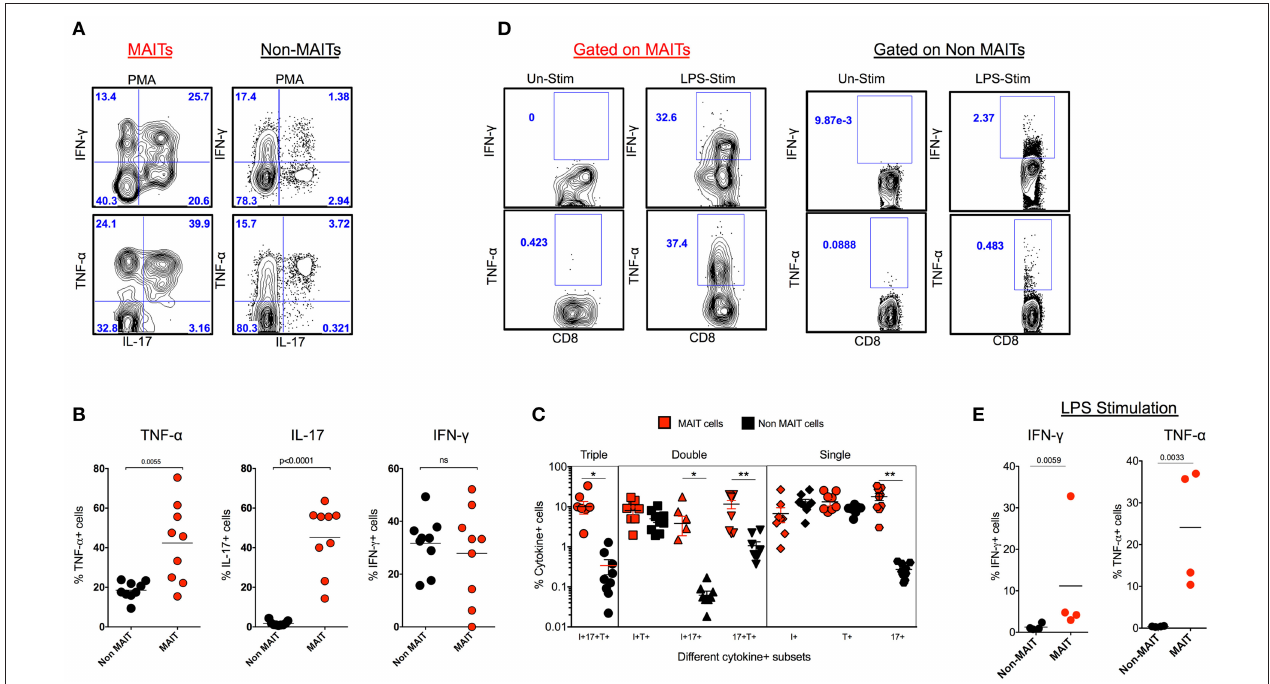
FIGURE 2 | MAIT cells are polyfunctional, and they predominantly make IL-17 in SHIV-naïve rhesus macaques. (A) Representative flow plots showing the production of cytokines IFN- γ , TNF- α and IL-17 by MAIT and non MAIT cells from SHIV-naïve animals. (B) Cumulative data for the production of cytokines from MAIT (red) and non-MAIT cells (black) from 9 SHIV-naïve animals stimulated with PMA/ionomycin. (C) Boolean analysis determining the co-expression pattern of IFN- γ , TNF- α , IL-17 by MAIT and non-MAIT cells. (D) Cytokine production capacity of MAIT and non-MAIT cells with LPS stimulation. (E) Cumulative data from four animals with LPS stimulation, LPS stimulates cytokine production capacity of MAIT cells. * P < 0.05 ; ** P <